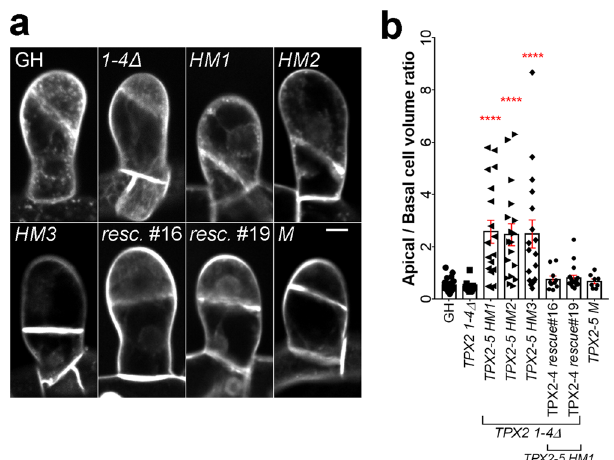
Fig. 4 Abnormal cell plate positioning in the gametophore initials of the TPX2-5 hypomorphic mutants. a Gametophore initial at the 2-cell stage stained with FM4-64 dye. Bar, 10 µ m. b The apical/basal cell volume ratio was estimated as the apical cell volume divided by the basal cell volume, measured during the 2-cell stage (mean ± SEM, **** p = 0.0001 by one way ANOVA with Dunnett ’ s multiple comparison test against GH). n = 22, 15, 18, 18, 17, 10, 18, and 8 for GH, TPX2 1-4 Δ , TPX2-5 HM1 , TPX2-5 HM2 ,